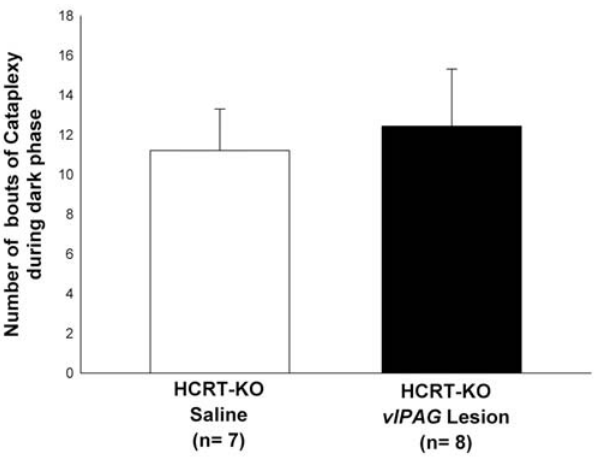
Figure 5. Mean ( 6 SEM) number of cataplexy bouts during the 12 h lights-off period in lesioned and non-lesioned (saline)